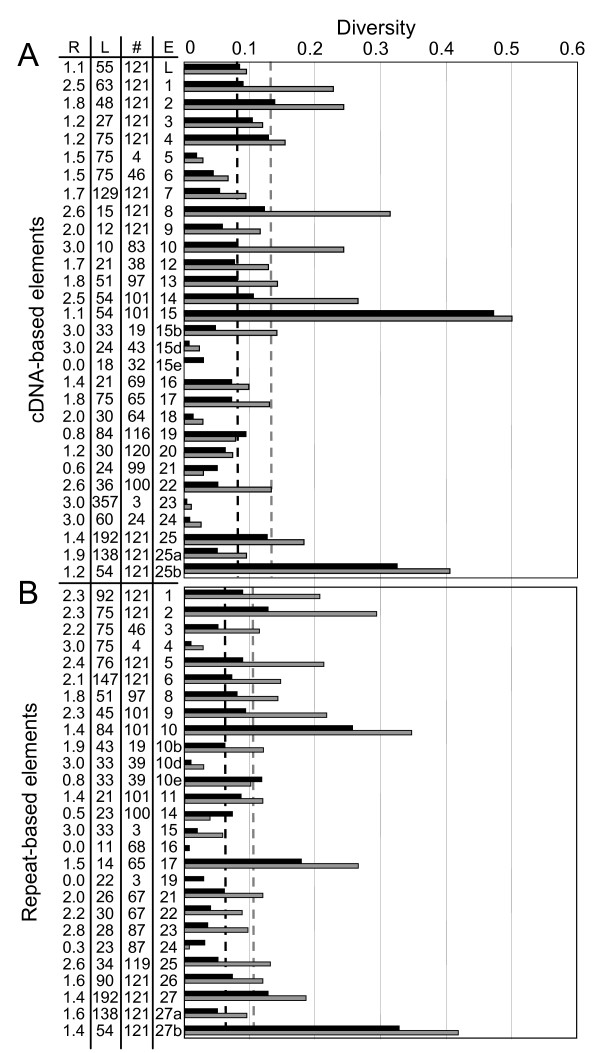
Diversity of the 185/333 gene elements. Nucleotide diversity scores (black bars) and amino acid diversity scores (gray bars) of individual exon elements are shown. The average element nucleotide diversity is indicated by a dashed black line and average element amino acid diversity is shown as a dashed gray line. The absolute range of diversity scores is 0 (entirely conserved) to 1.609 for nucleotide alignments (based on an even distribution of five states: four nucleotides and a gap) or 3.044 for amino acid alignments (21 possible states) [30]. The highest element diversity score previously observed was from element 11 (0.5381) from a set of cDNAs isolated from bacterially-challenged coelomocytes pooled from five animals [30]. This score was similar to that obtained from a modeled element in which 40% of the positions contained four different states in 20% of the sequences. Elements with a diversity score of 0 were omitted (Ex11, Ex15a, Ex15c, and Ex15f-g of the cDNA-based alignment (A) and Er7, Er10a, Er10c, Er10f-g, Er12 -13, Er18, and Er20 of the repeat-based alignment (B). The number (#), length in nucleotides (L) and nucleotide to amino acid diversity ratio (R) are indicated in the table to the left of the graphs. Ex25 includes both Ex25a and Ex25b. Ex25a includes all sequences from the start of Ex25 up to and including the first stop codon. Ex25b includes only the sequence following the first stop codon to the second stop codon (Additional file 2 and Additional file 3). Element Er27 in the repeat-based alignment (B) is treated similarly.